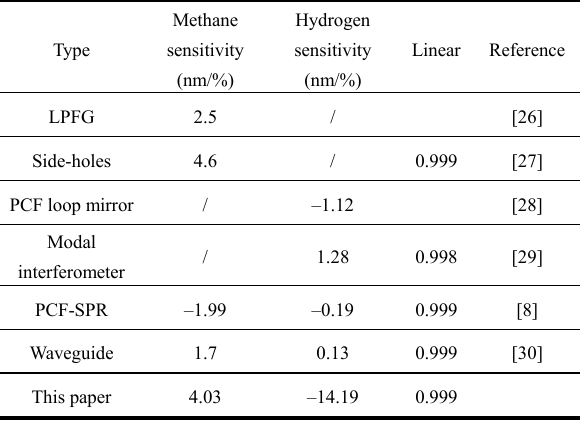
Table 3 Comparison of photonic crystal fiber